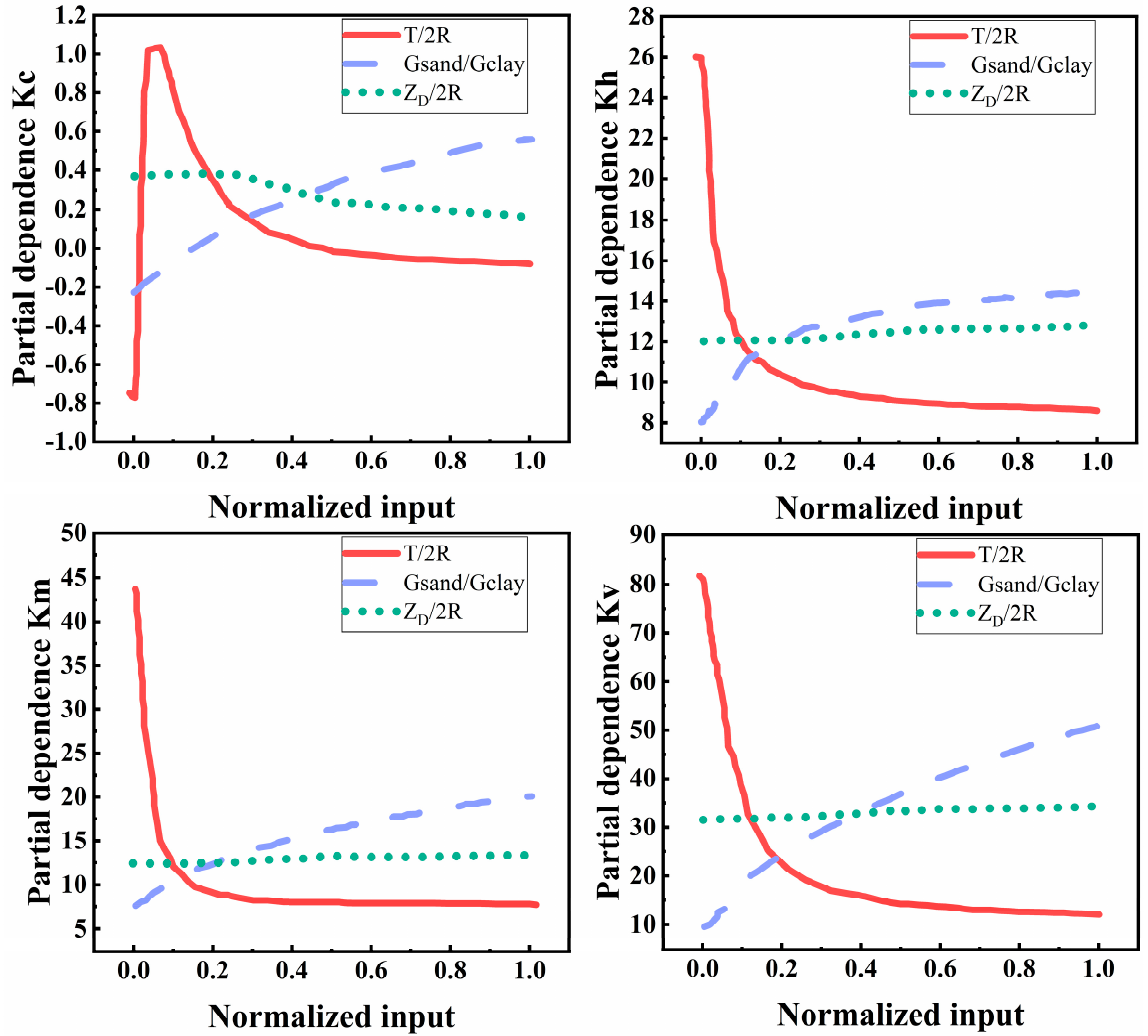
Figure 12. PDPs of T/2R, G sand /G clay, and Z D /2R for all output variables. Note that the features were normalized so that their influences on the output could be better compared.